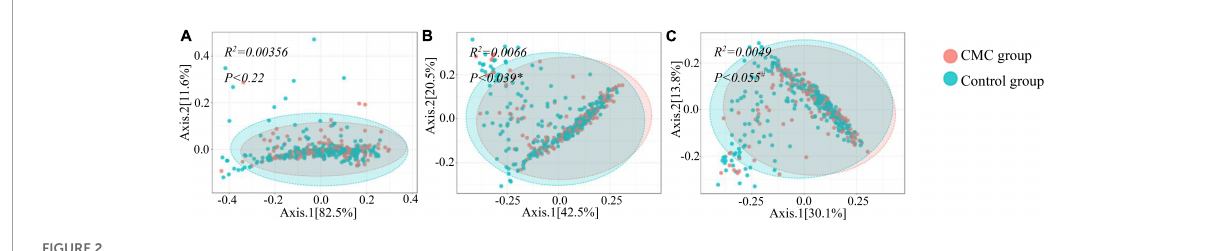
FIGURE2 Beta diversity of subjects grouped by CMC status. (A–C) depict beta-diversity of gut microbiota according to Bray–Curtis (BC) distance via principal coordinates analysis (PCoA) method. (A) Phylum, (B) Genus, (C) Species. Data were normalized via the TSS method, PERMANOVA (Permutational ANOVA) test was applied to detect the difference significance in the two groups and # P < 0.1 or ∗ P < 0.05 .